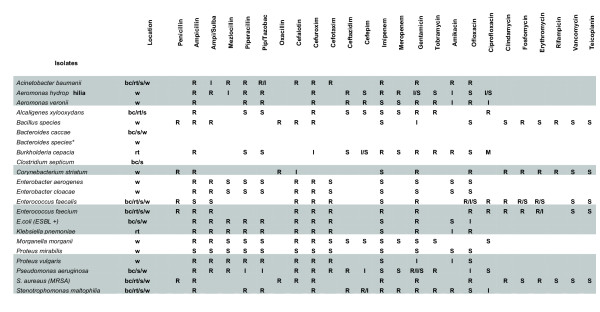
Resistance patterns for isolates from blood cultures, respiratory tracts, serum, and wounds. Isolates with multiple resistancies are in bold. aLocation: bc, blood culture; rt, respiratory tract; s, serum; w, wounds. bB. distasonis, fragilis, thetaiotaomicron. ESBL, extended-spectrum β-lactamase; I, intermediate sensitive; R, resistant; S, sensitive.